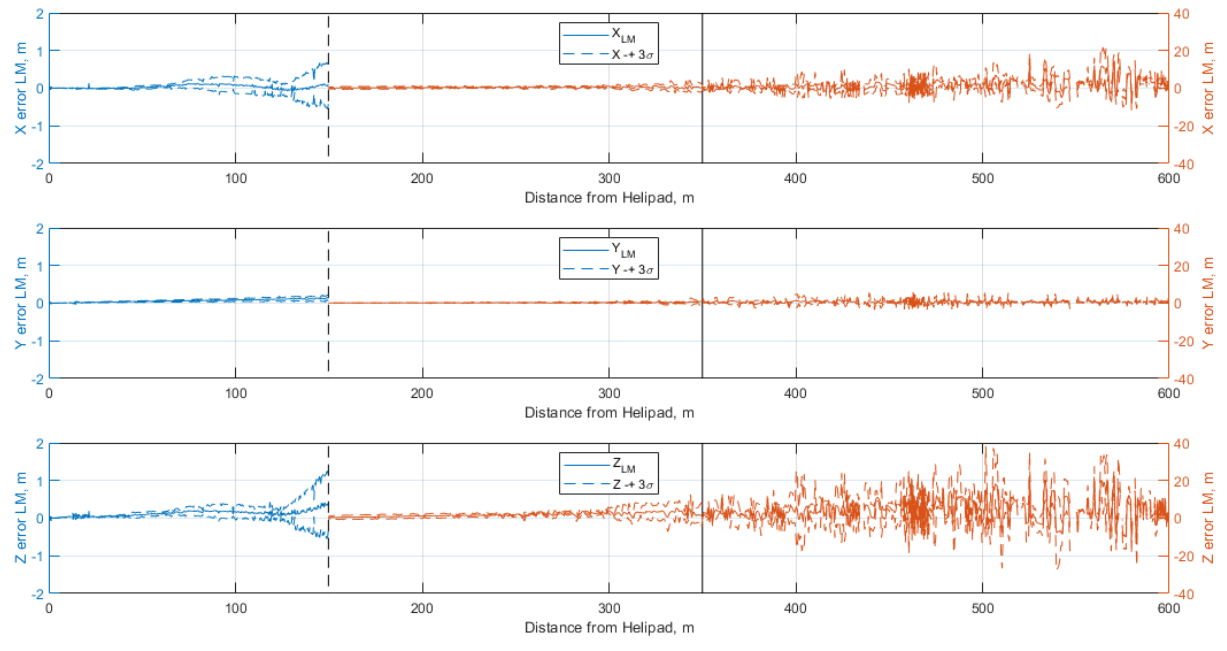
Figure 10. LM position estimates errors average over 50 simulations and 3 − sigma bounds. VTCA landing trajectory in nominal visibility conditions. The plot scale is increased in the last 150 m to better show the errors in the final phase of the approach. The 350 m distance (black vertical line) from the landing pad is the selected threshold for TPVF.